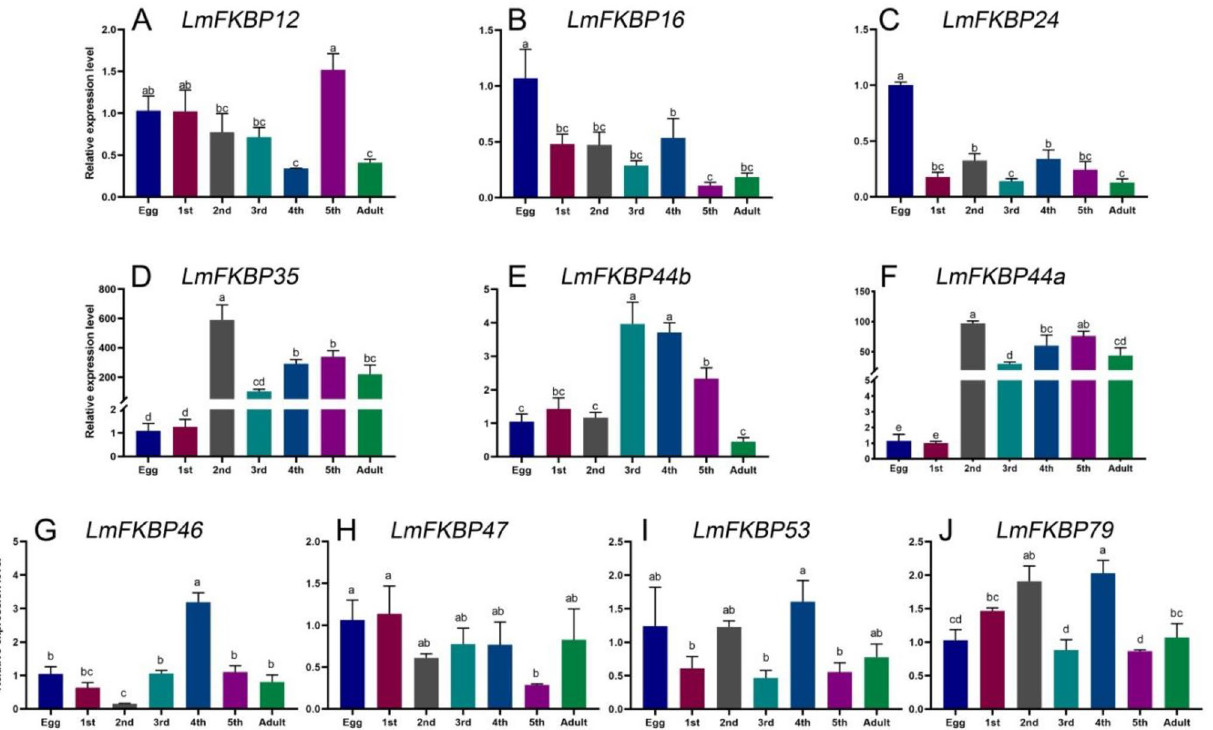
Figure 4. Expression patterns of 10 FKBPs at different developmental stages of L. migratoria . Bars represent Mean ± SEM (standard error of mean) (n = 3). The genes expressions at the egg stage were taken as the control. Different lowercase letters indicate significant differences in relative expression levels ( P < 0.05). The X axes in ( A – J ) show the analyzed developmental stages of L. migratoria , including eggs and nymphal instars (1st + 2nd = first and second instars, 3rd = third instar, 4th = four instar, 5th = fifth instar). ( A – J ) are the relative expression levels of LmFKBP12 , LmFKBP16 , LmFKBP24 , LmFKBP35 , LmFKBP44b , LmFKBP44a , LmFKBP46 , LmFKBP47 , LmFKBP53 , LmFKBP79 at different developmental